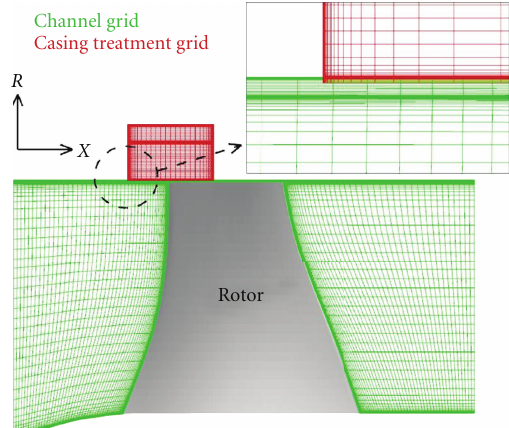
Figure 6: Chimera mesh used for modelling the slot-type CT of the CBUAA case.